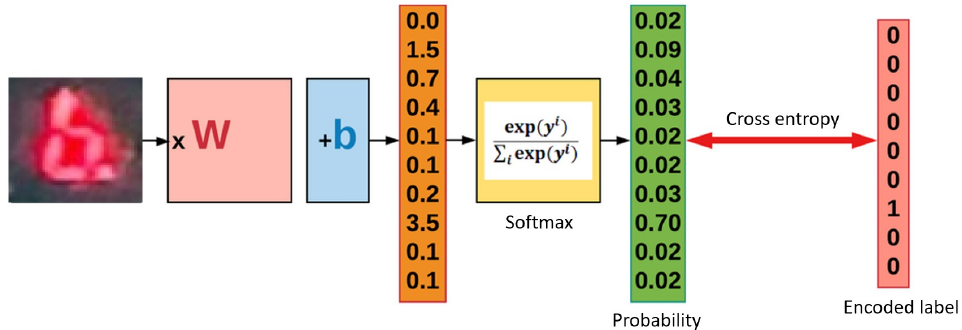
Figure 7. The algorithm of feature extraction on TensorFlow Lite with a simple logistic regression structure.